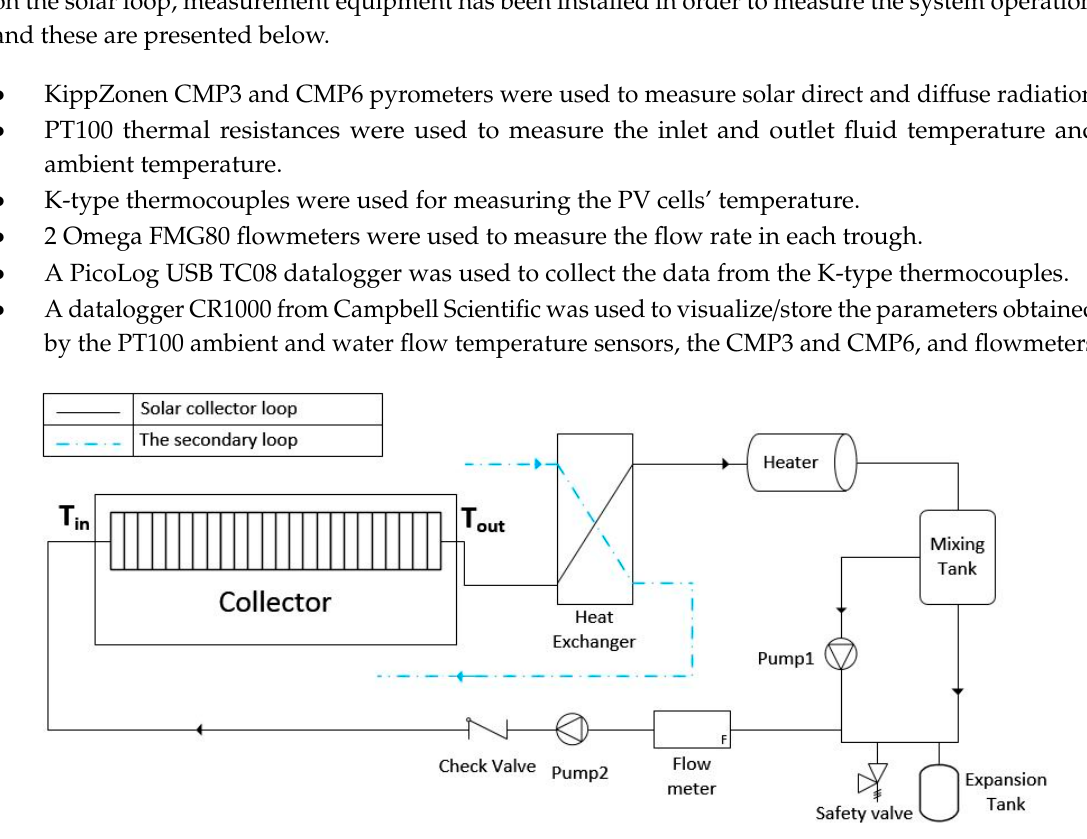
Figure 8. Schematic of the experimental setup .